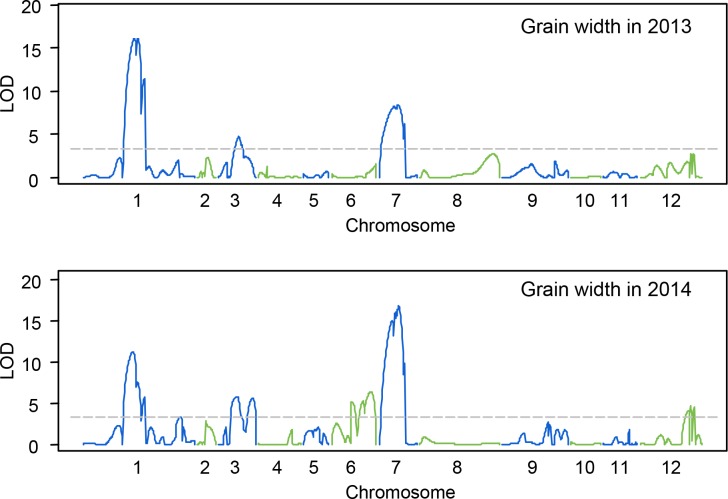
Graph for QTL mapping results of grain width of BC3F1 population in 2013 and 2014.